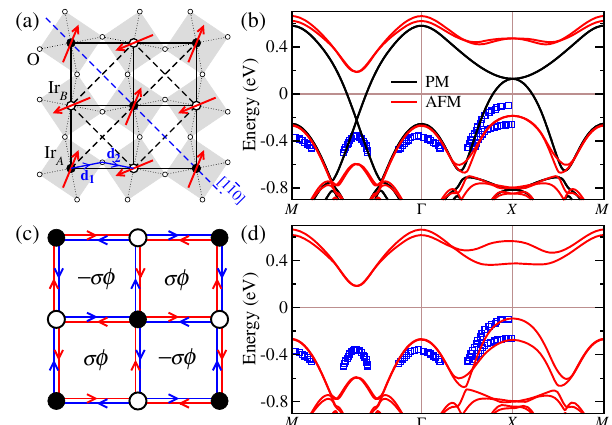
FIG. 3. (a) Schematics of the in-plane canted AFM moments on the Ir square lattice with a two-dimensional rendering of the staggered IrO 6 octahedral rotation. (b) QP band dispersion in the canted AFM state (red solid lines) and the nonmagnetic state (black solid lines) at ð U; J Þ ¼ ð 1 . 2 ; 0 . 05 Þ eV and x ¼ 0 . (c) Sche- ¼ 1 = 2 pseudospin current order and matics of the d -wave J eff associated staggered pseudospin flux Φ σ ¼ (cid:2) σϕ . (d) QP band ¼ dispersion in the canted AFM state with coexisting d -wave J eff 1 = 2 pseudospin current corresponding to Δ ¼ 30 meV. Open d blue squares are data from ARPES experiments